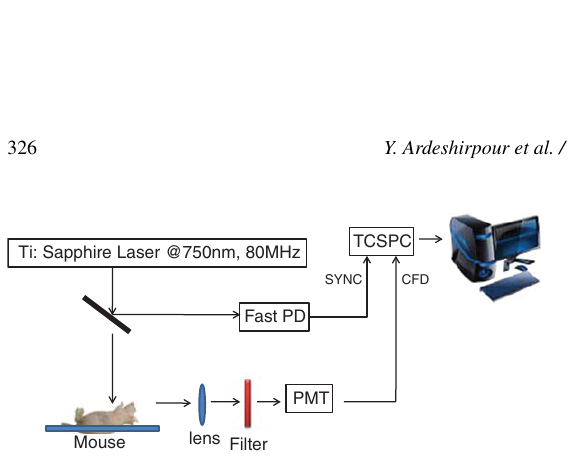
Fig. 5. Schematic of our time-resolved small animal imaging system. (ROI) and position the scanner of the time domain system to the ROI. The same camera was used with- out the filter to capture the white light image of the small animal. The field of view of the CCD camera was 12 × 12 cm 2 . The time domain system consisted of